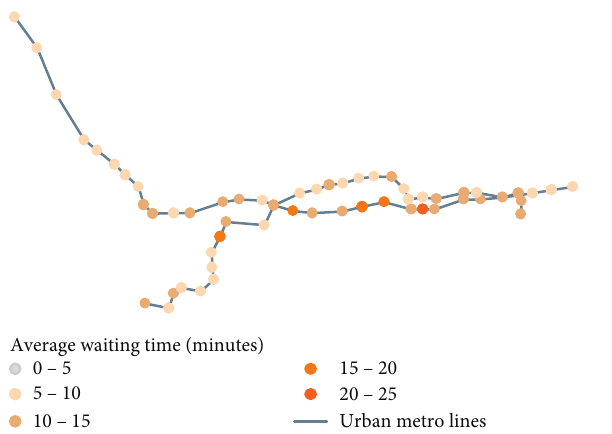
Figure 9: The average waiting time of passengers at each station of Shenzhen metro Line 1 and Line 2.